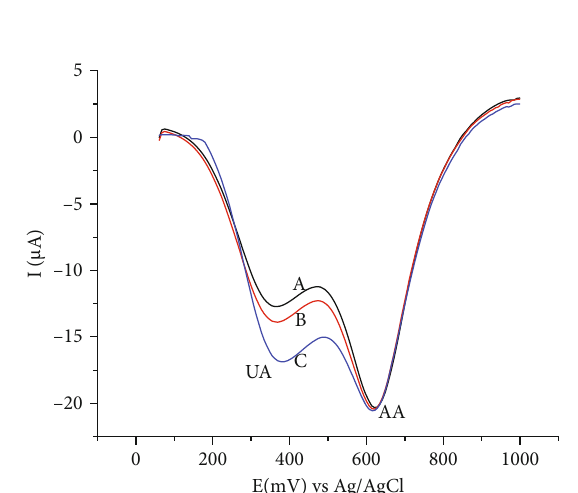
Figure 11: E ff ect of interference on the anodic peak current of 1.6 mM AA at various concentrations ((a) 0.5mM, (b) a +1.0 mM, (c) a +2.0 mM) of UA.